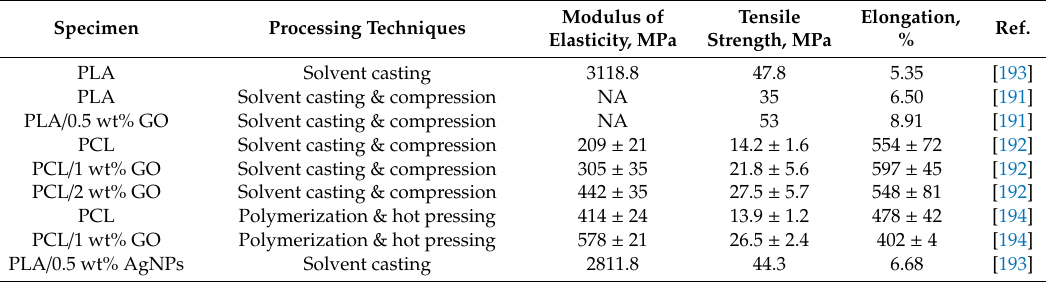
Table 1. Tensile properties of PLA / GO and PCL / GO solid thin